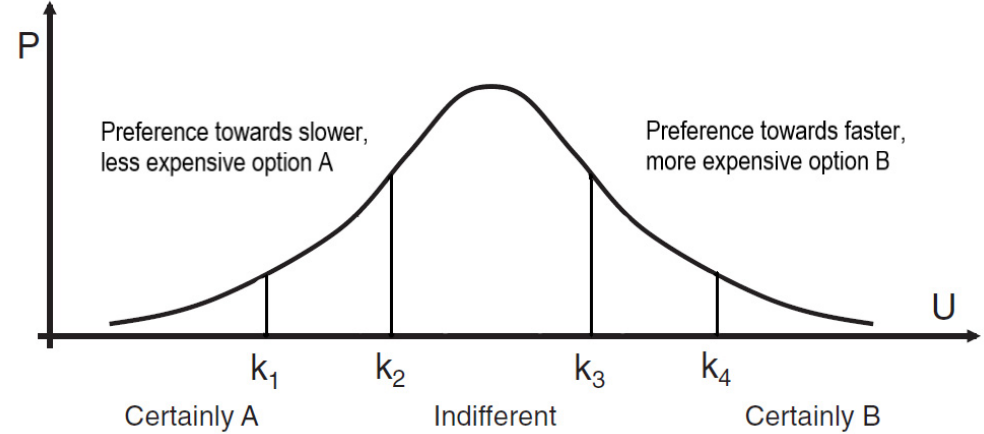
Figure 2. Choice probability distribution of the respondents’ preference; adapted from [32].